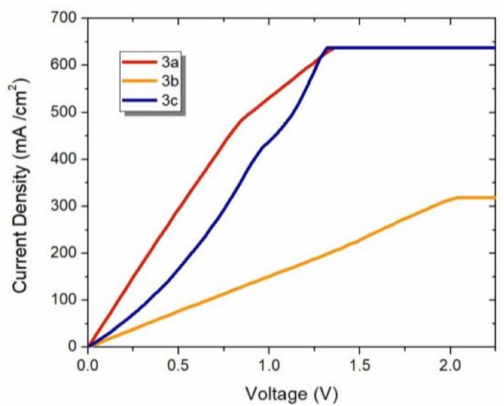
Figure 6. J - V characteristics of 3a , 3b and 3c thin films under white light illumination, at room temperature ( 3a = 2-pyridyl; 3b = 3-pyridyl; 3c = 4-pyridyl derivative).